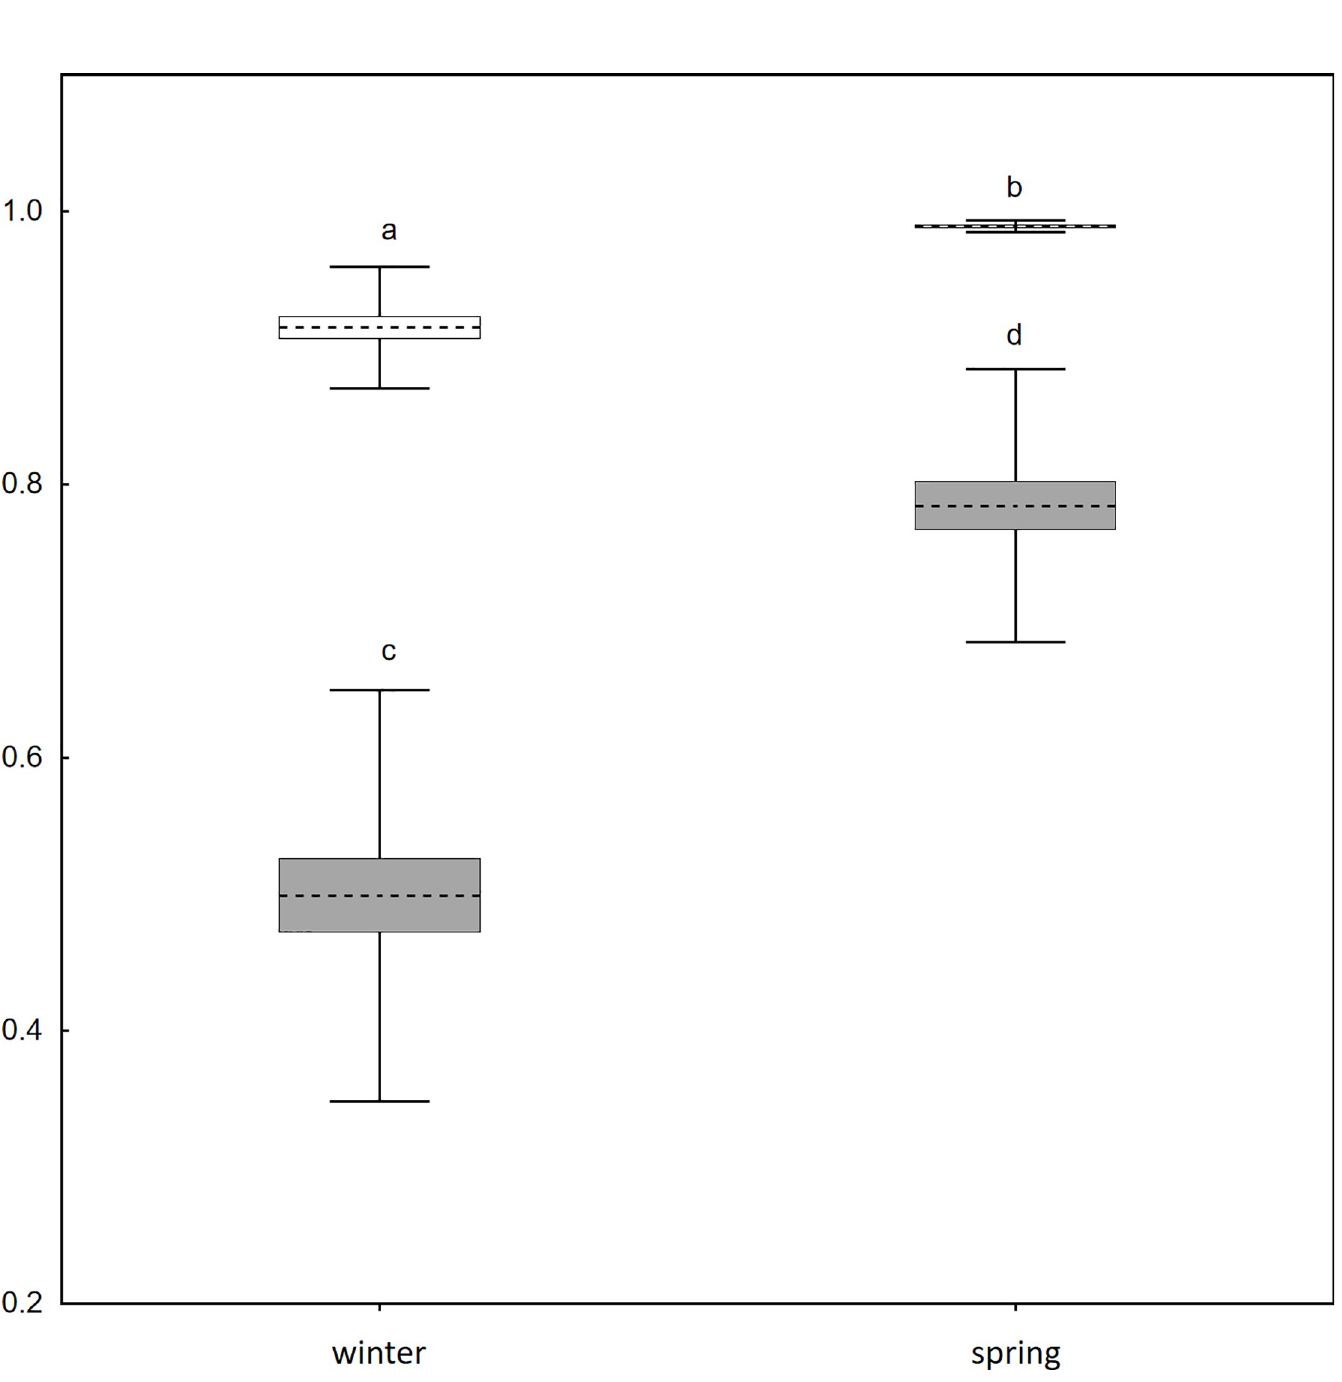
Fig 4. Seasonal difference in degree and clustering coefficient of space sharing networks. Boxes (grey–degree, clear–clustering coefficient) represent mean ± standard error; whiskers represent standard deviation; significance—ab,cd p <